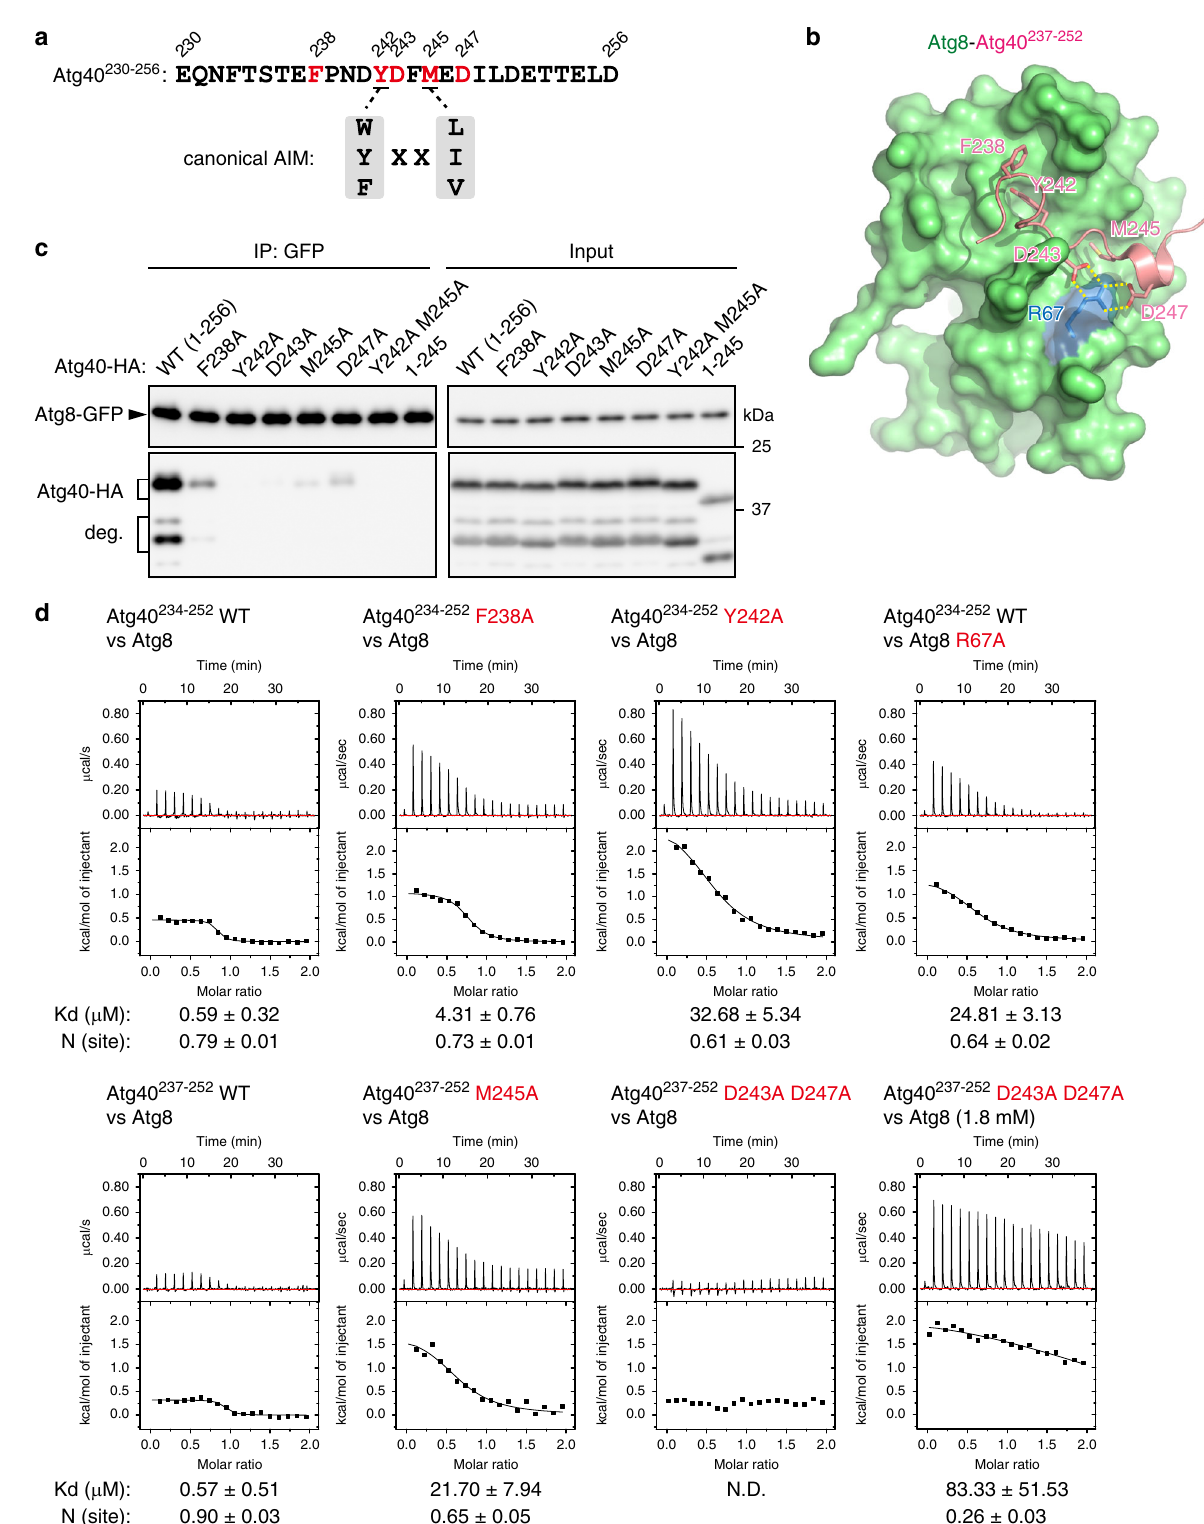
Fig. 5 The structural basis of the Atg40 – Atg8 interaction. a Amino-acid sequences of the canonical AIM and the C-terminal region of Atg40 (230 – 256). The residues colored red were replaced with alanine in c . b Crystal structure of Atg8-Atg40 237 – 252 . Yellow dashed lines, salt bridges. c ATG8-GFP atg4 Δ atg40 Δ cells expressing Atg40-HA were treated with rapamycin for 6 h, and the cell lysates (input) were subjected to immunoprecipitation using anti-GFP antibody. The immunoprecipitates (IP) are analyzed by immunoblotting using antibodies against GFP and HA. Additional bands in Atg40-HA immunoblotting represent its degradation products (deg.). The experiments were repeated independently twice. d Binding af fi nity of Atg40 peptides to Atg8 was measured by